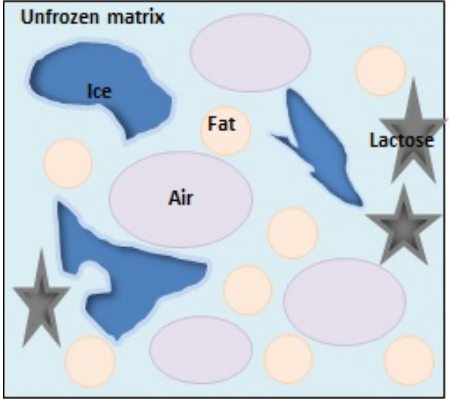
Figure 5. Schematic diagram showing the complex microstructure of ice cream visible during micro-CT analysis (own work, based on Guo et al., 2017 [57]).